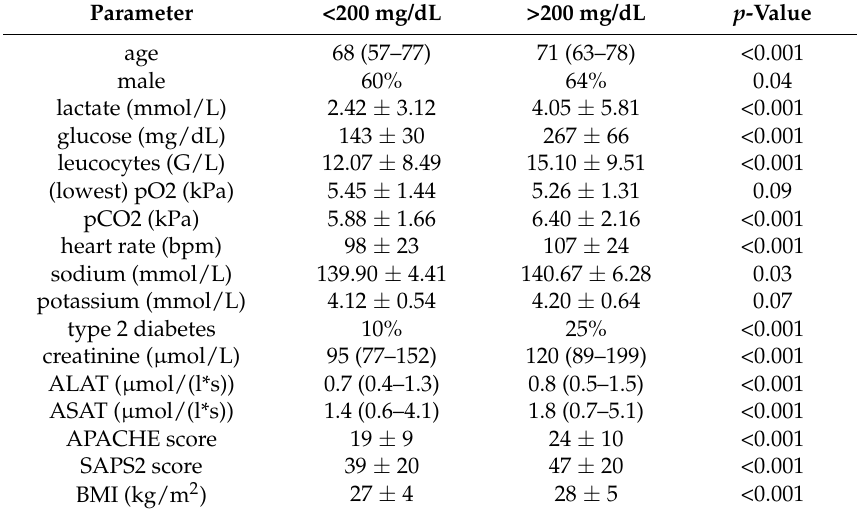
Table 3. In the overall cohort, patients suffering from severe hyperglycemia (>200 mg/dL) were sicker (SAPS2 score 47 ± 20 vs. 39 ± 20; p < 0.001) and older (71 (62–78) vs. 68 (57–77) years; p < 0.001).